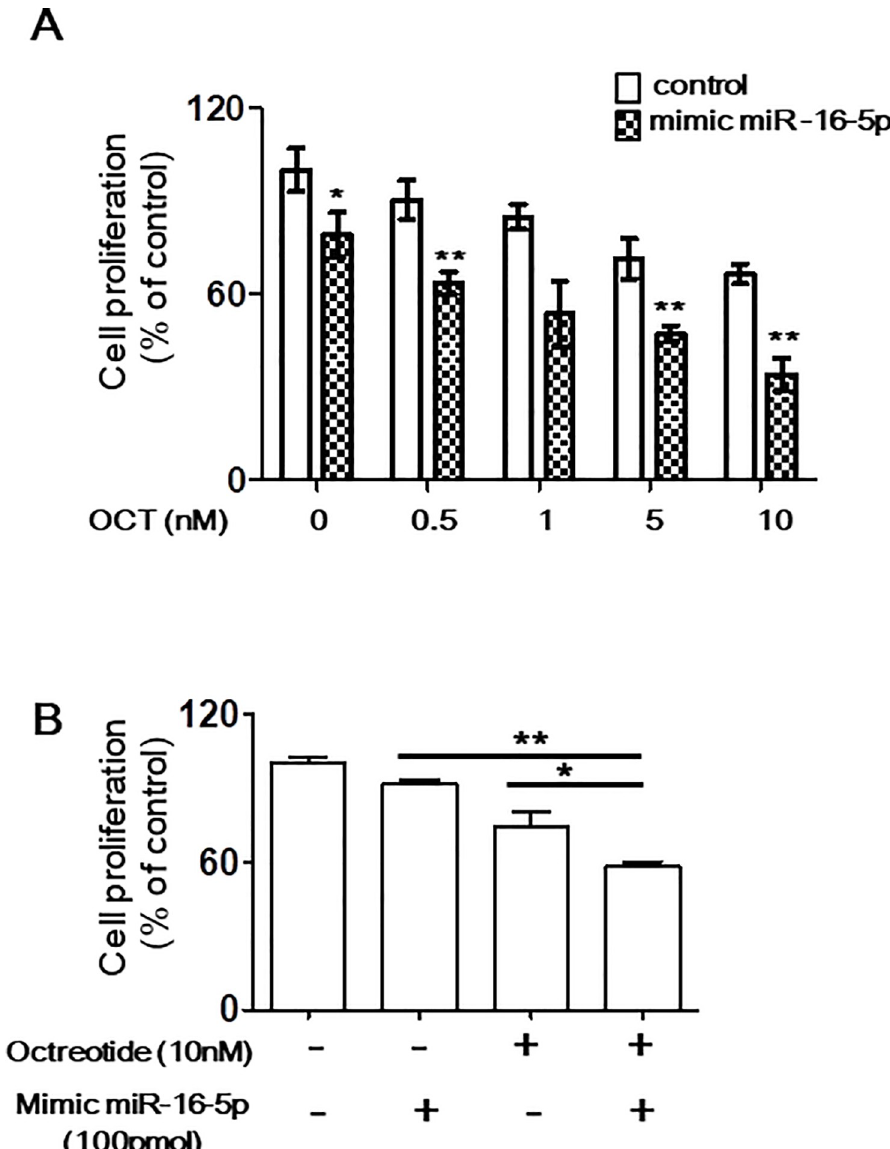
Fig 5. Sensitivity of INS-1 cells to octreotide after treatment with mimic miR-16-5p. (A) INS-1 cells were transfected with 2.5 pmol of mimic miR-16-5p or control miRNA for 24 h and treated with the indicated concentration of octreotide for 24 h. Cell proliferation was measured in a CCK-8 assay. (B) Spheroids from miR-16-5p mimic- or control-transfected INS-1 cells were treated with octreotide for 48 h. The proliferation of six spheroids were measured by CellTiter-Glo 1 3D Cell Viability Assay. Values represent the mean of three independent experiments ± SD; � p < 0.05, �� p < 0.01.